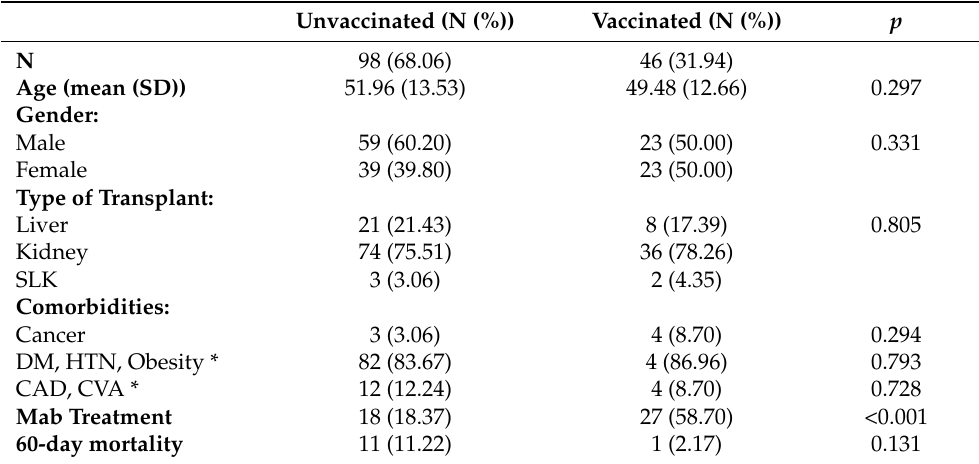
Table 1. Demographics, Treatments, and Outcomes by Vaccine Status (N = 144).